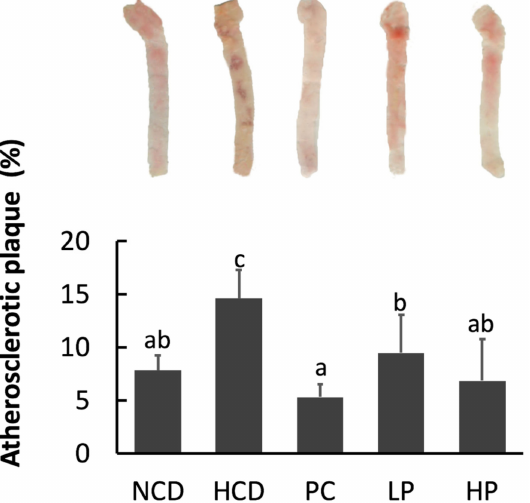
Figure 4. Aorta atherosclerotic plague area in hamsters fed one of the five diets: NCD, no cholesterol diet; HCD, high cholesterol diet containing 0.1% cholesterol; PC, high cholesterol diet containing 0.5% cholestyramine; LP, high cholesterol diet containing a low dose (0.1%) soybean germ phytosterols (SGP); HP, high cholesterol diet containing a high dose (0.2%) of soybean germ phytosterols (SGP). n = 8 for each group. a,b,c = means with di ff erent superscript letters di ff er significantly at p < 0.05.